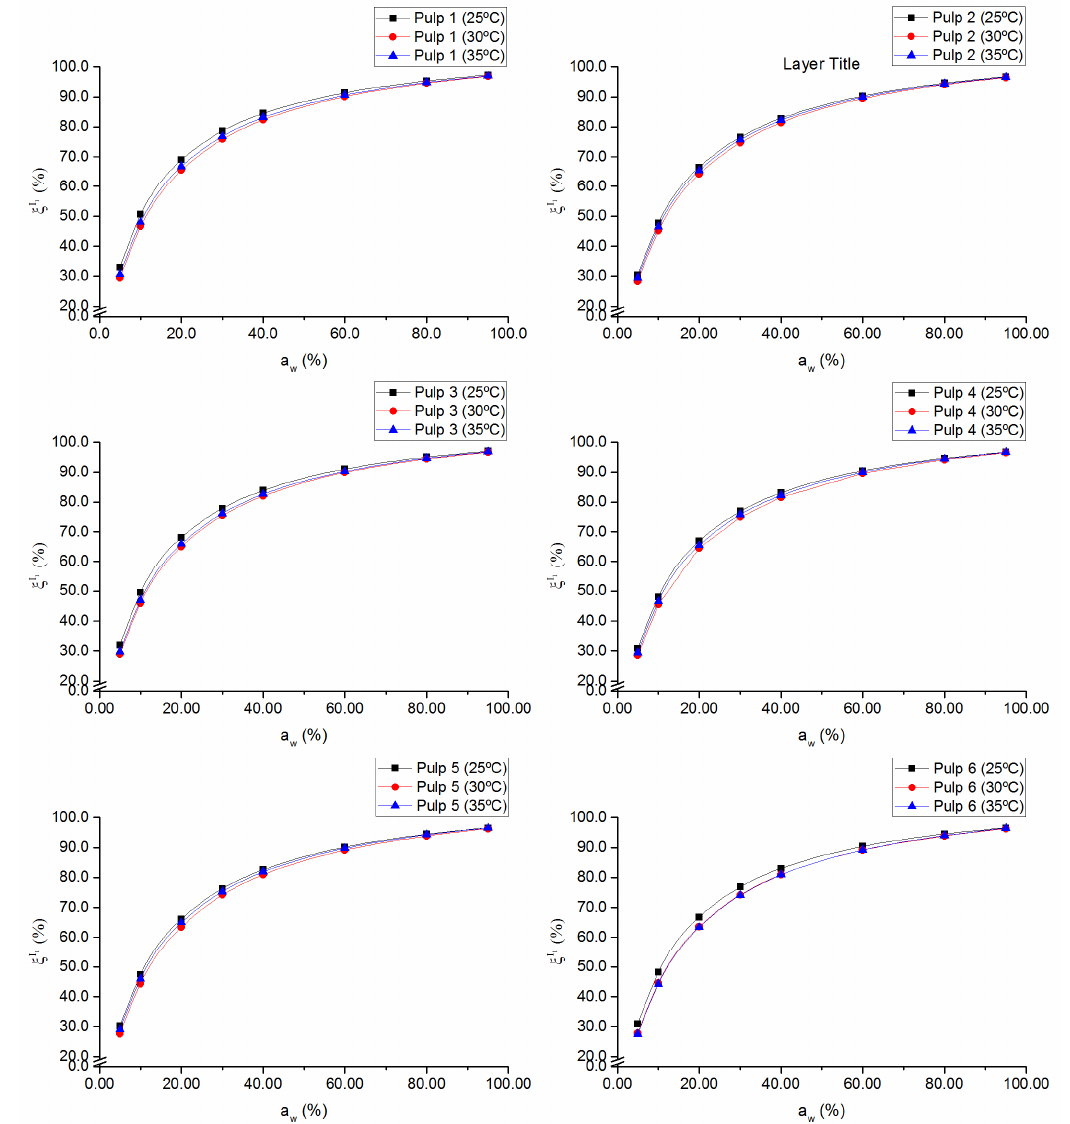
Figure 4. Fraction of occupied sites in the monolayer ( ξ l 1 ) for 1 – 6 pulps as a function of water activity at 25, 30, and 35 °C.